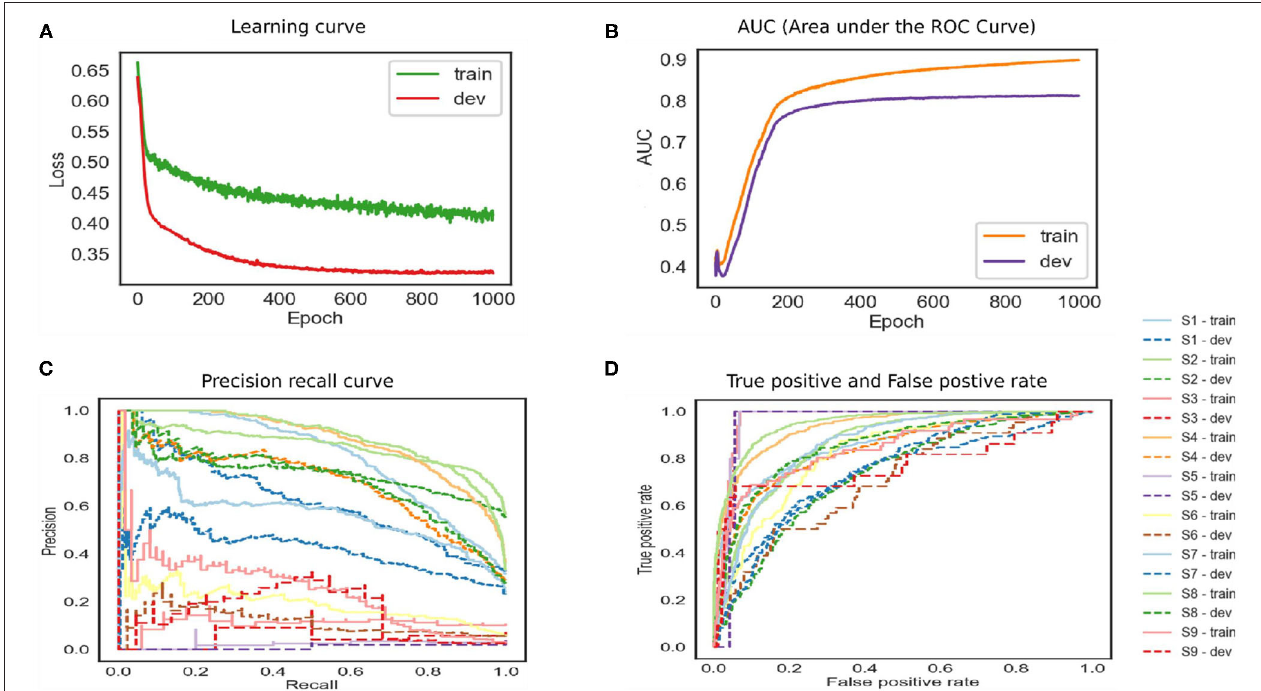
FIGURE 3 | The feed-forward neural network baseline